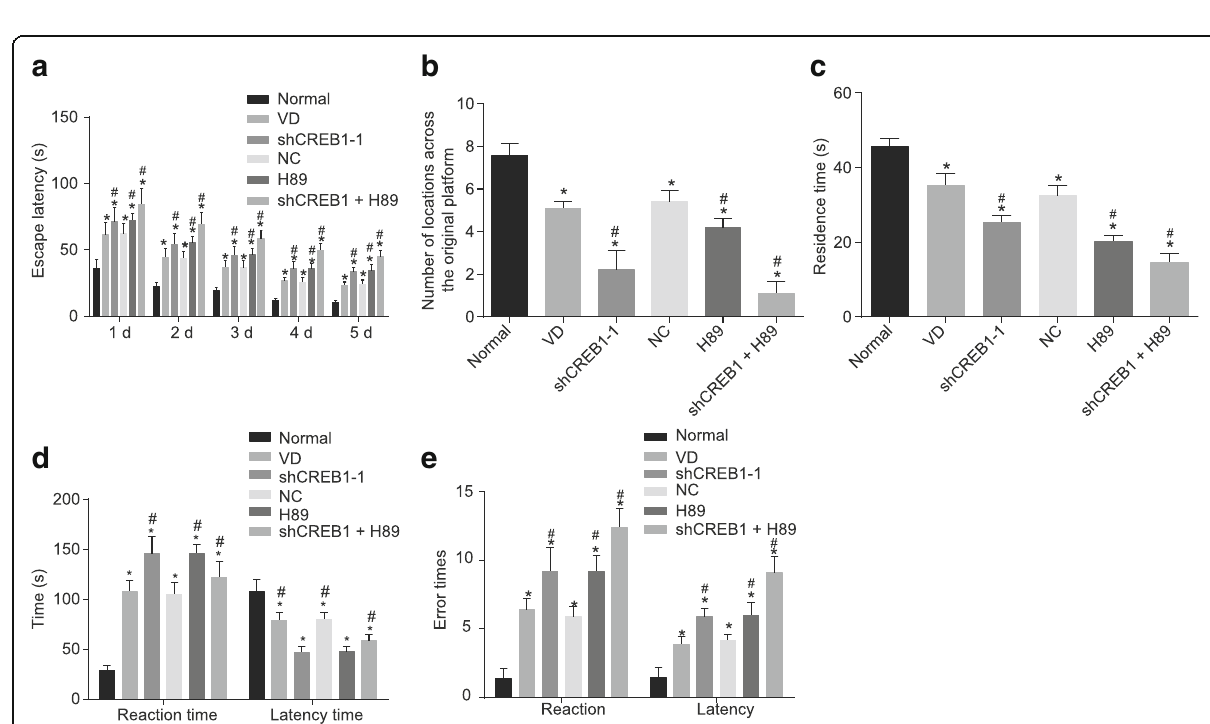
Fig. 2 Cognitive functions of mice injected with shCREB1 – 1 or/and H89 are impaired, Notes: A, the latent time of each group of mice; B, the number of crossing the original platform in each group; C, residence time of each group in the original platform quadrant; D, reaction time and latent time histogram; E, histogram of error times; * , p < 0.05, compared with the normal group; # , p < 0.05, compared with the VD group; VD, vascular dementia; CREB1, cyclic adenosine monophosphate responsive element-binding protein 1